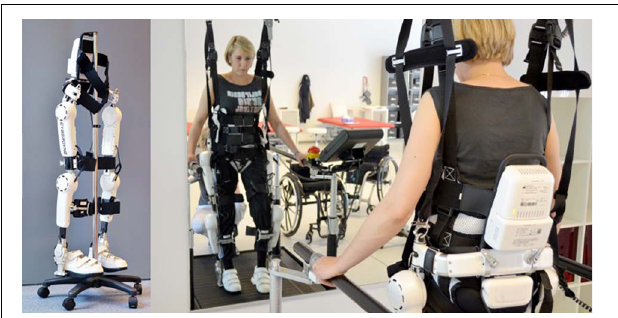
FIGURE 2 | HAL exoskeleton and training setting. Left part of the figure shows HAL exoskeleton with its electronic actuators for hip and knee joints (“power units”), its battery pack and controller at the top and its EMG-electrodes and cables for detection of bioelectrical signals. Right part of the figure demonstrates the training setting with the treadmill, the body-weight support and the exoskeleton. Official picture of Cyberdyne Inc., the person was not subject of the published study and has been engaged and paid for commercials. Copyright Cyberdyne, Inc., published with kindly permission.